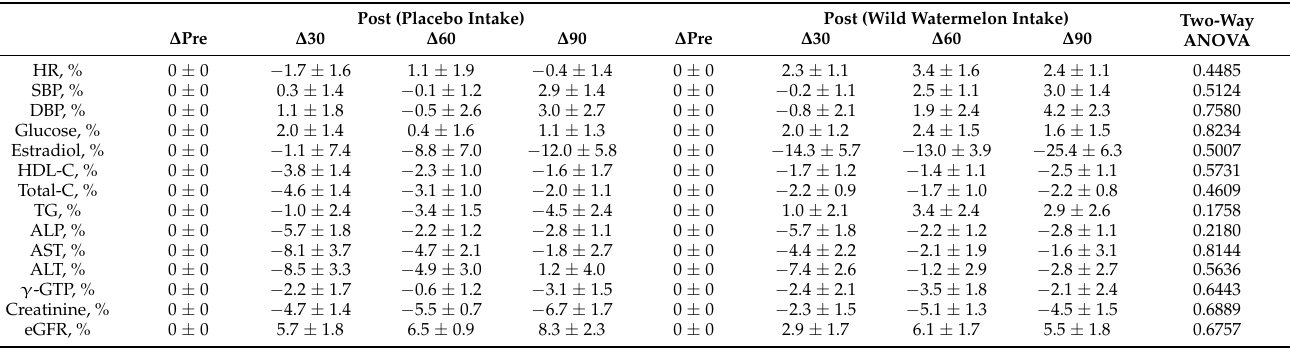
Figure 1. Time course changes in brachial-ankle pulse wave velocity (baPWV) ( A ), carotid-femoral PWV (cfPWV) ( B ), and femoral-ankle PWV (faPWV) ( C ) between wild watermelon and placebo groups. Data are expressed as mean ± standard error. * p < 0.05, vs. placebo group. Table 2. Percent changes in hemodynamics and metabolic parameters at pre, post-30min, post-60min, Table 1. Comparison of characteristics in placebo and watermelon intake groups. and